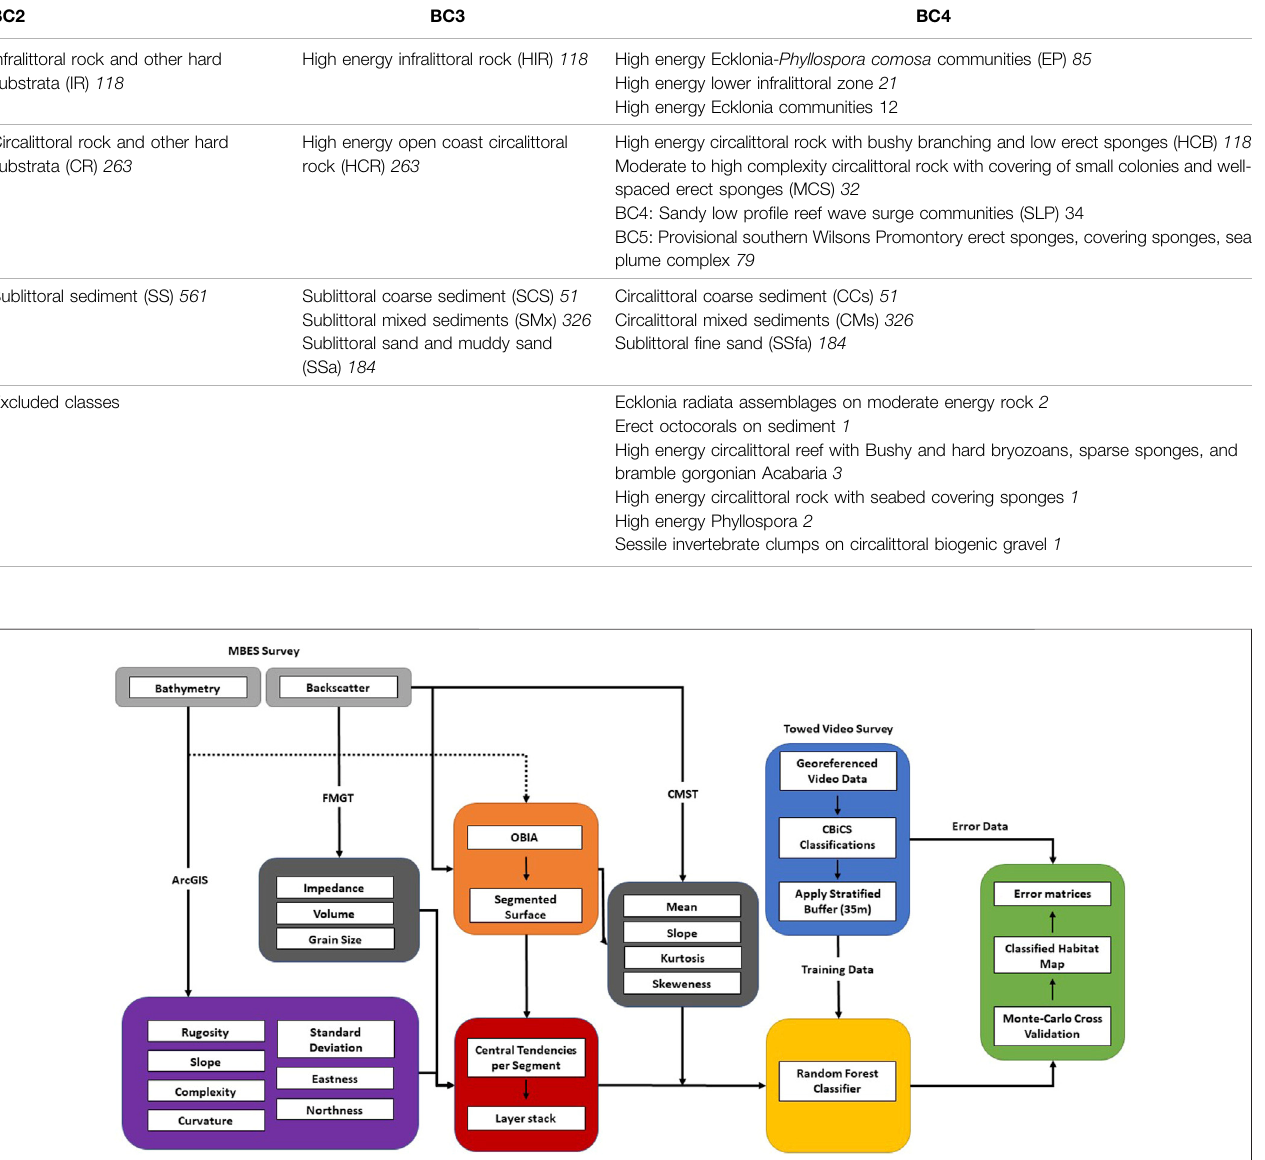
TABLE 2 | Combined Biotope Classi fi cation Scheme (CBiCS) hierarchies (BC2, BC3, BC4) used to train and validate the three hierarchical models in the present study. Number of observed classes from groundtruth data ( italicized ) for each level class. BC2